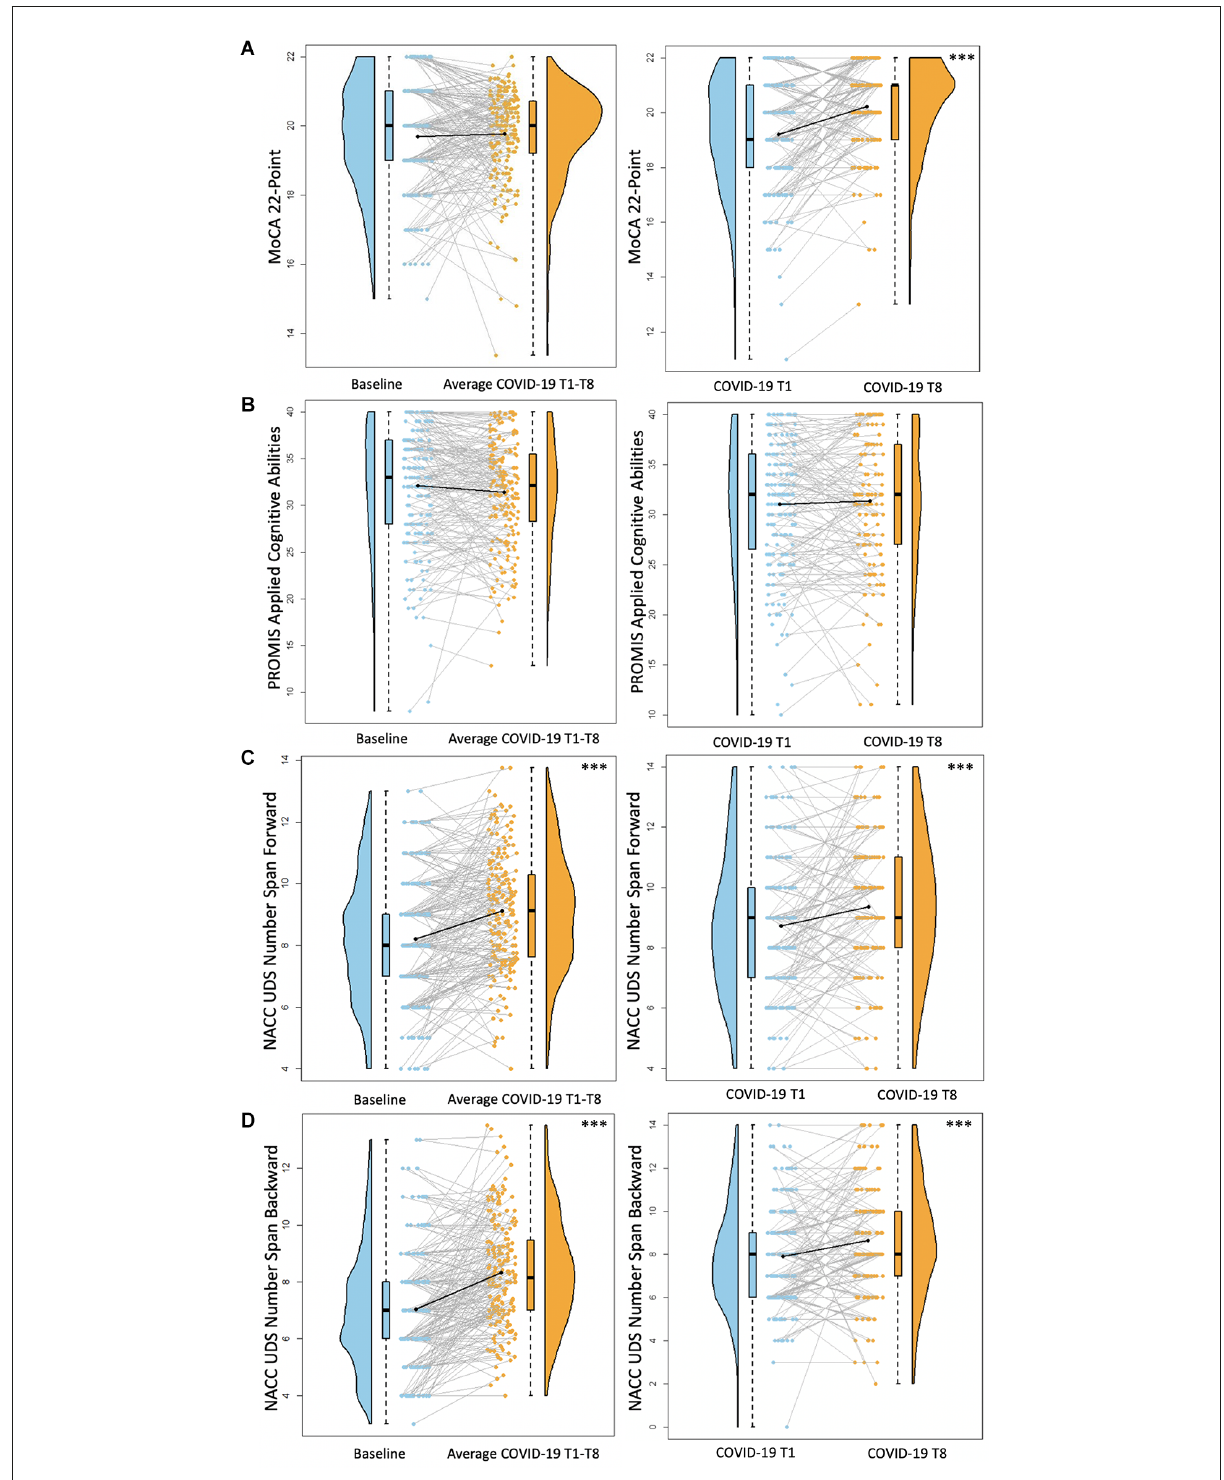
FIGURE4 Cognitive functioning results. Plots depicting the raw distribution of data points collected for (A) Montreal Cognitive Assessment (MoCA) 22-point version, (B) Patient-Reported Outcomes Measurement Information System (PROMIS)–Applied Cognitive Abilities, (C) National Alzheimer’s Coordinating Center Uniform Data Set (NACC UDS) Number Span Forward, and (D) NACC UDS Number Span Backward. The plots on the left side of the panel represent change from pre-pandemic baseline to during the pandemic (average of COVID-19 timepoints 1–8), while the plots on the right side of the panel represent change throughout the pandemic (COVID-19 timepoint 1 vs. timepoint 8). ∗∗∗ p <